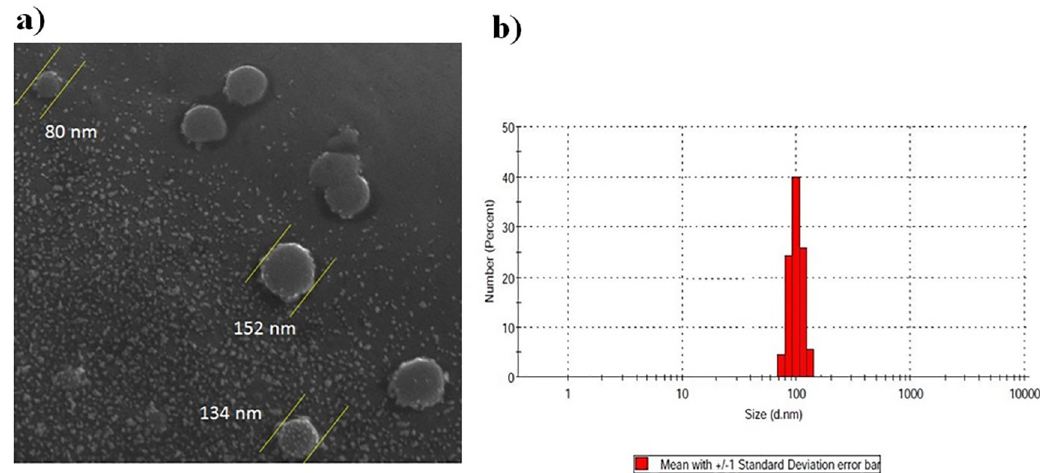
Fig 1. SEM (a) and DLS (b) images of isolated EVs show the morphology and size of EVs.